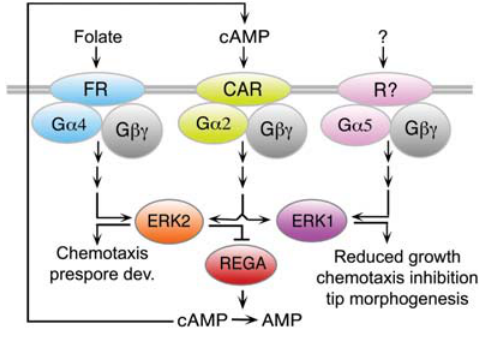
Figure 3 Dictyostelium MAPK signaling downstream of three G- protein-mediated signaling pathways. The cell surface receptors – folate receptor (FR), cAMP receptor (CAR), unknown receptor (R?) – couple to different G a subunits and can activate one or both ERKs. ERK1 function is required for G a 5 subunit-pathway responses and ERK2 is required for G a 4 subunit-pathways responses. ERK2 can inhibit the cAMP specific phosphodiesterase, REGA, increasing the level of cAMP available for cell